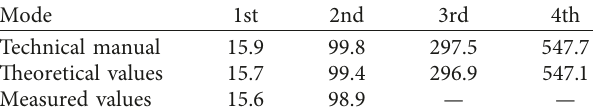
Figure 8: Structure diagram of cantilever beam: (a) planar beam element and (b) distribution of nodes for the cantilever beam. Table 4: Comparison of natural frequencies for technical manual, theoretical, and measured values (Hz).